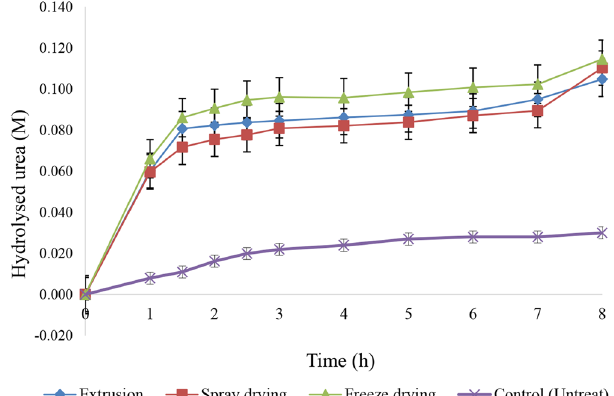
Figure 4. Hydrolyzed urea concentration (M) by microencapsulated bacterial spores in mortar. Data are shown as the mean ± SE, derived from three replications. For the three encapsulation methods, no means were significantly different to the others (p >